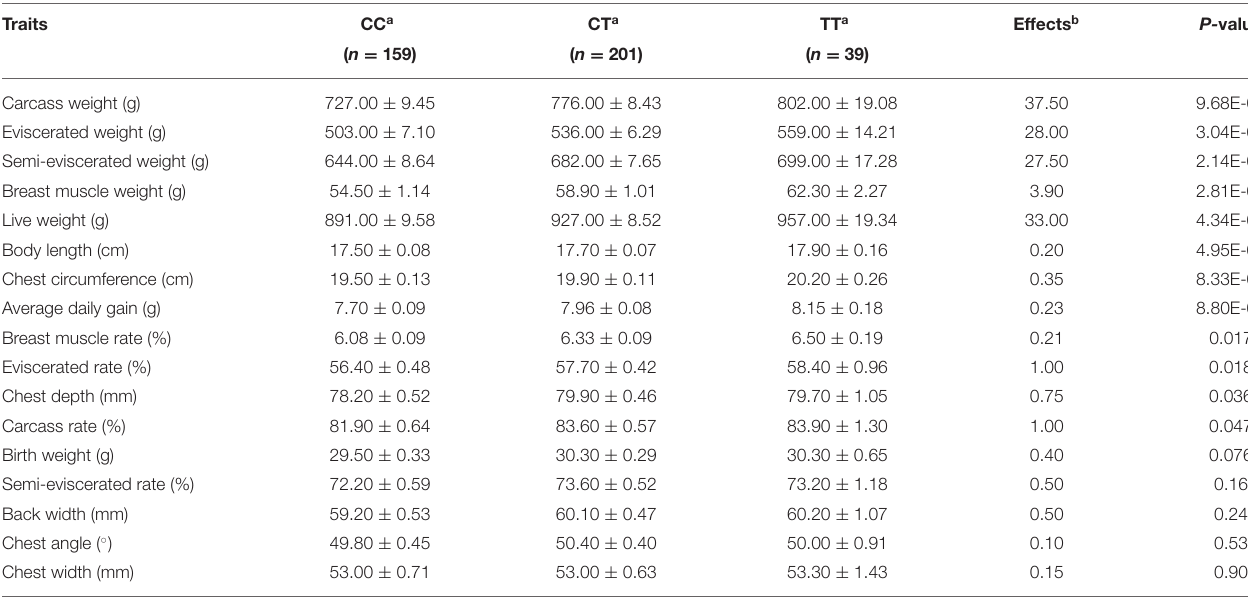
TABLE 3 | The effects of the SNP rs16400745 on traits related to growth and carcass.